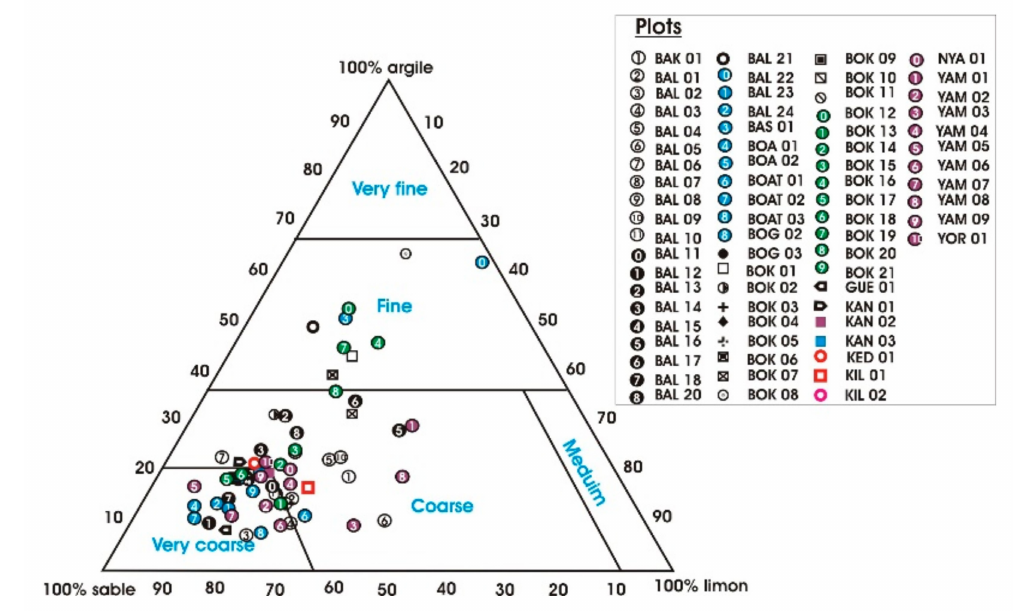
Figure 3. Textural diagram of Jamagne.